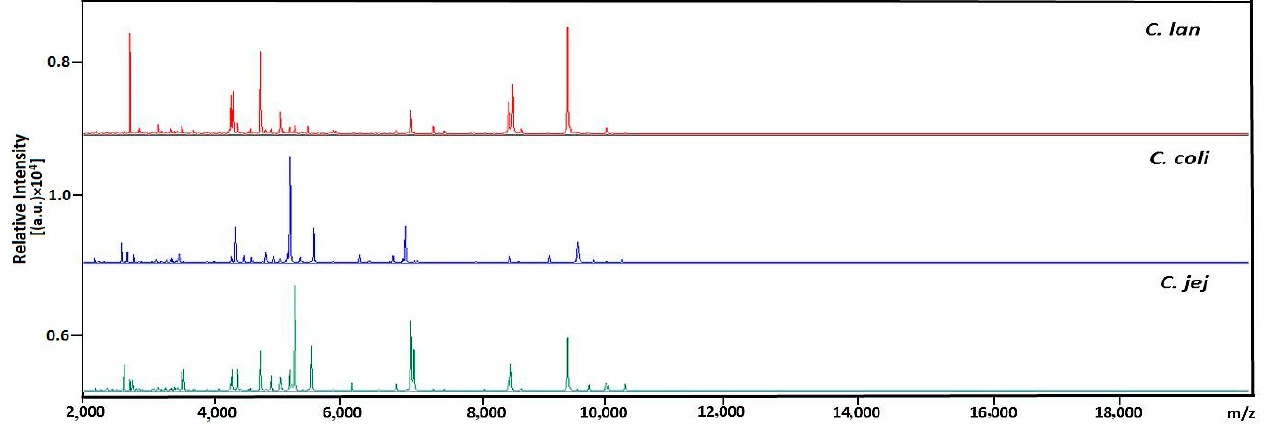
Figure 1. Characteristic spectra of C. jejuni , C. coli and C. lanienae isolates generated by the Bruker Ultraflextreme MALDI TOF system. The intensities and m/z of the ions are shown on the Y- and X-axis, respectively.